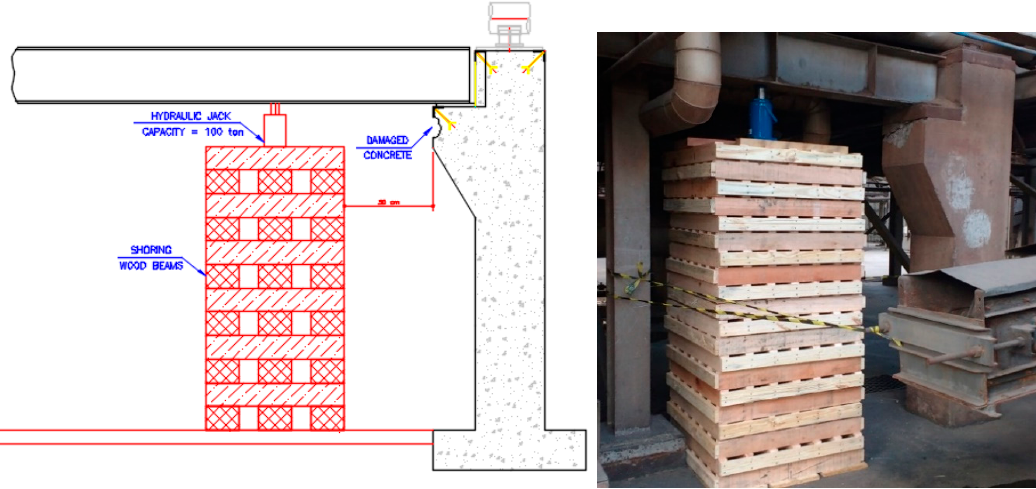
Figure 7. Jacking of the W ‐ beam in order to relieve the reinforced concrete corbel to be repaired.